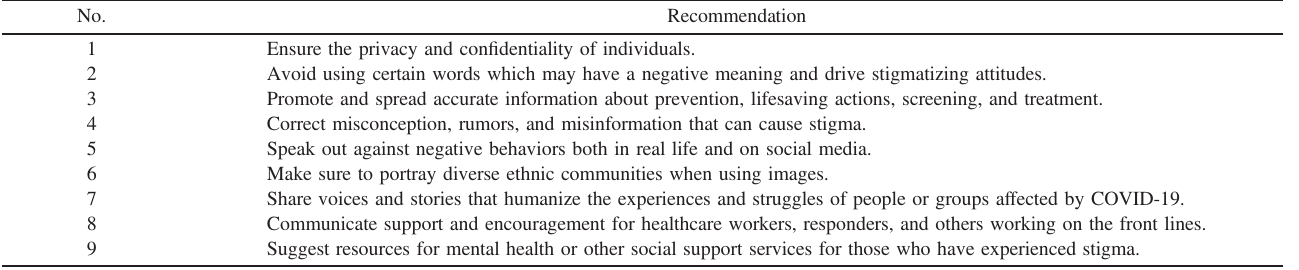
Table 1. Recommendations for preventing and addressing stigma associated with COVID-19